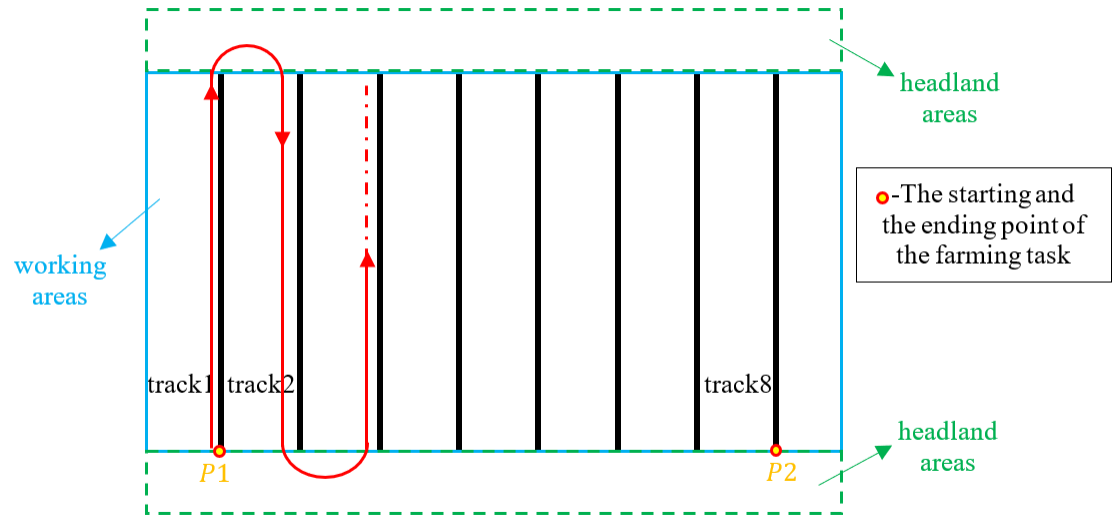
Figure 2. The given optimized tracking trajectory by the operational layer (red curves).